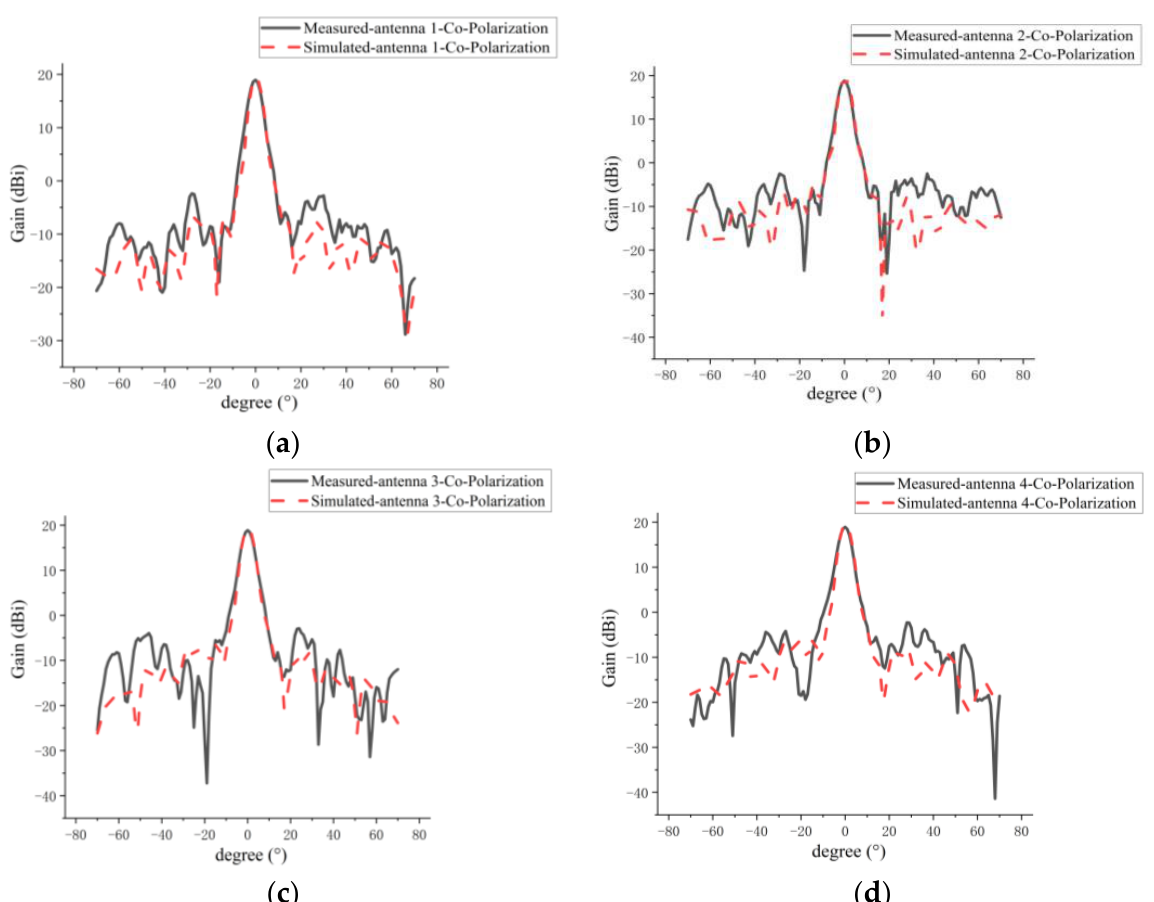
Figure 22. Comparison between measured and simulated H-plane co-polarization patterns of every antenna element in sparse array: ( a ) grid antenna 1; ( b ) grid antenna 2; ( c ) grid antenna 3; ( d ) grid antenna 4.